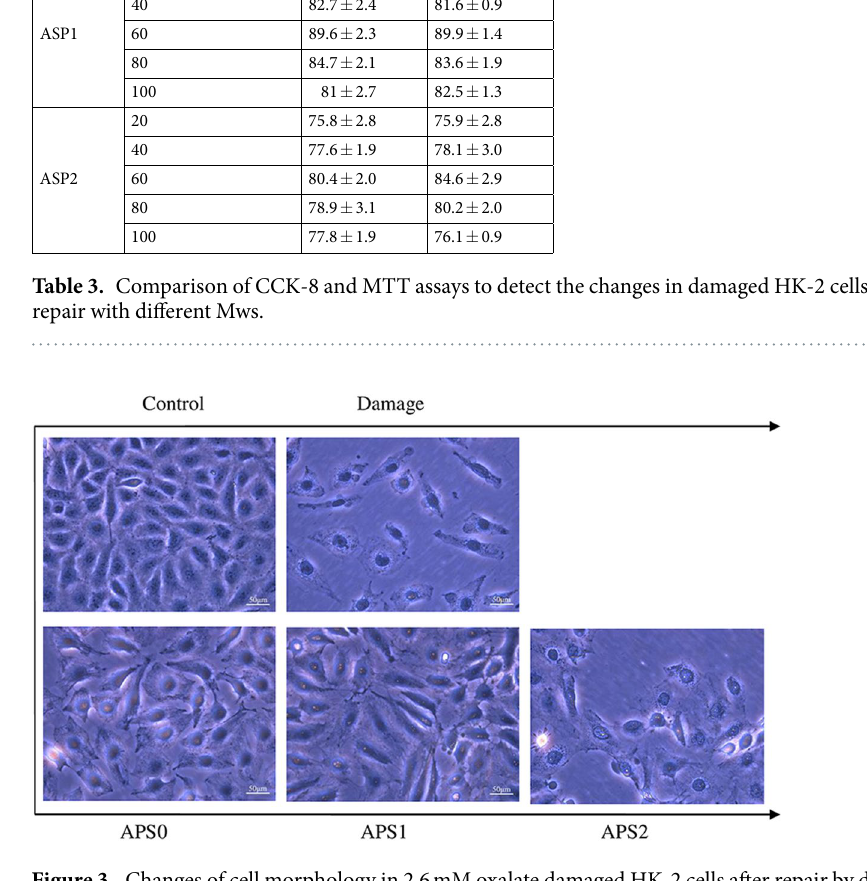
Figure 3. Changes of cell morphology in 2.6 mM oxalate damaged HK-2 cells after repair by different Mw APS (60 μ g/mL) for 10